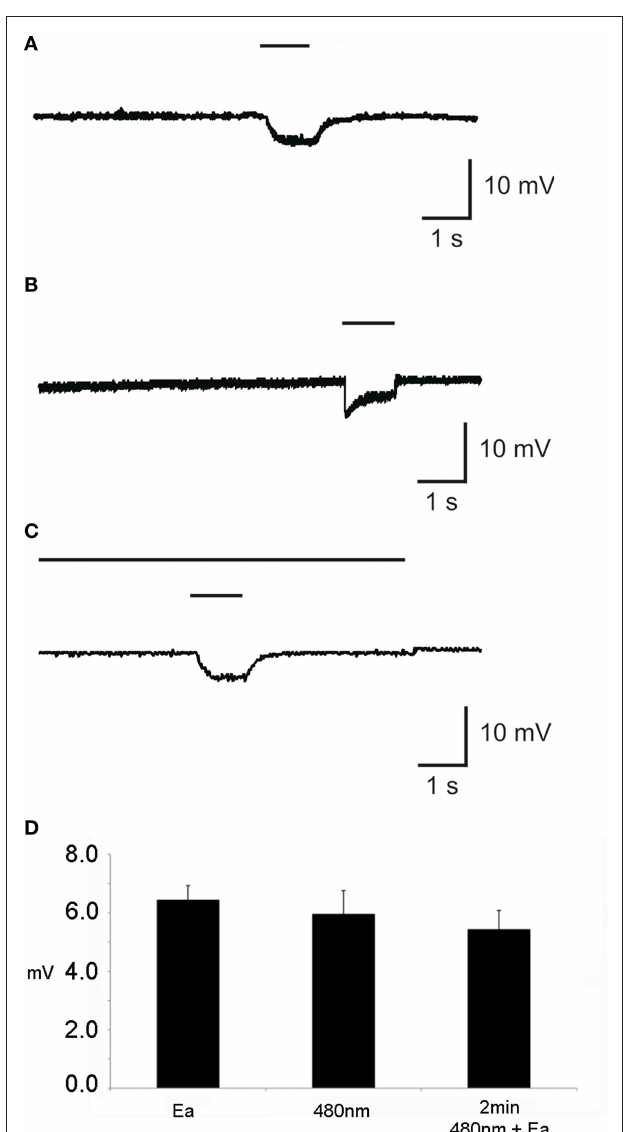
Figure 2 | individual elecrophysiological recording from the dorsal organ of the third instar larvae (eDg) with (A) application of pure ethyl acetate and (B) application of light at 480 nm wavelength for 1 s each. (C) Application of light for 2 min with simultaneous application of ethyl acetate (Ea) for 1 s. (D) The mean of EDG response ( n = 10) in mV in response to the application of either Ea or 480 nm or Ea together with 480 nm. The upper bar indicates the duration of stimuli with 480 nm, whereas the lower short bar represents the stimulation with